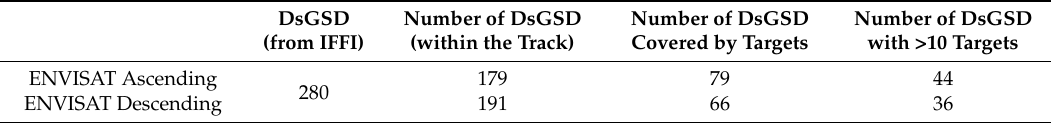
Table 3. Summary of the number of deep-seated gravitational slope deformations (DsGSDs) inventoried in the IFFI project covered by targets generated by the GPOD-SBAS process. DsGSD Number of DsGSD Number of DsGSD Number of DsGSD (from IFFI) (within the Track) Covered by Targets with >10 Targets 280 ENVISAT Descending 191 ENVISAT Ascending 179 79 44 280 ENVISAT